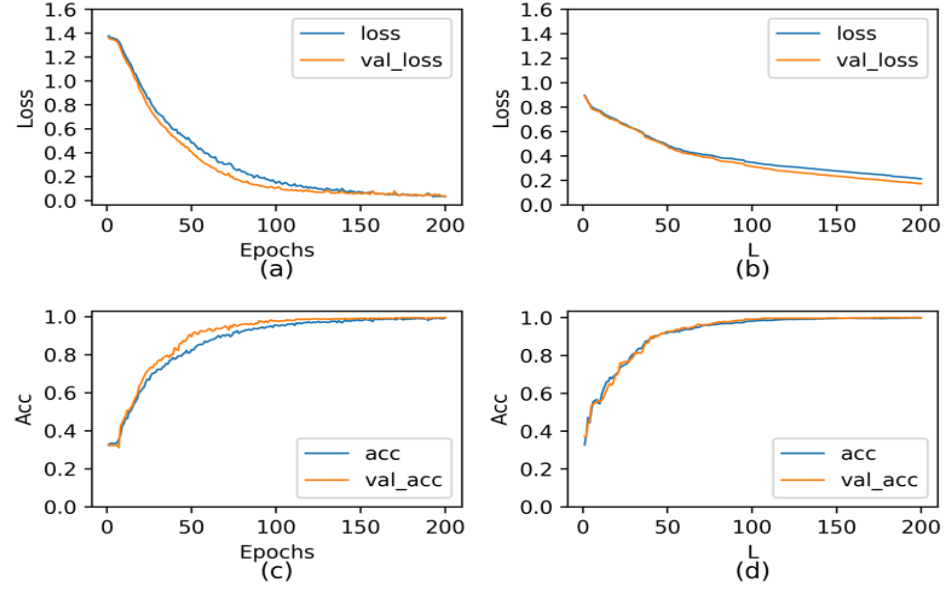
Figure 14. ( a ) Error curves of CNN; ( b ) Error curves of SCN; ( c ) Accuracy curves of CNN; ( d ) Accuracy curves of SCN.